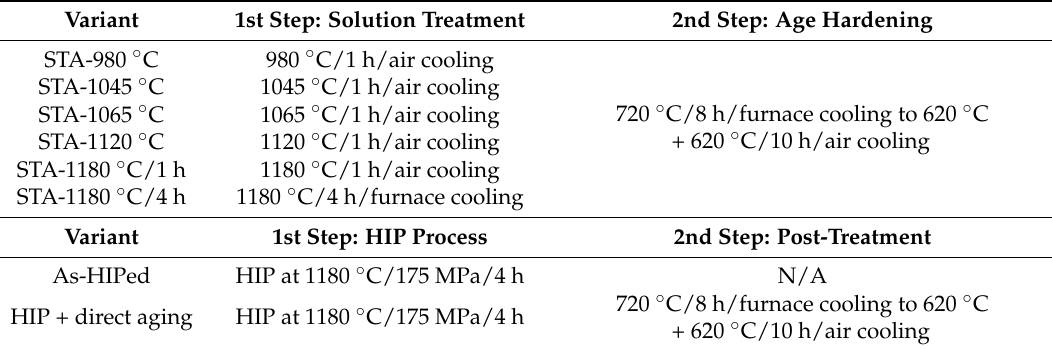
Table 2. Post-process